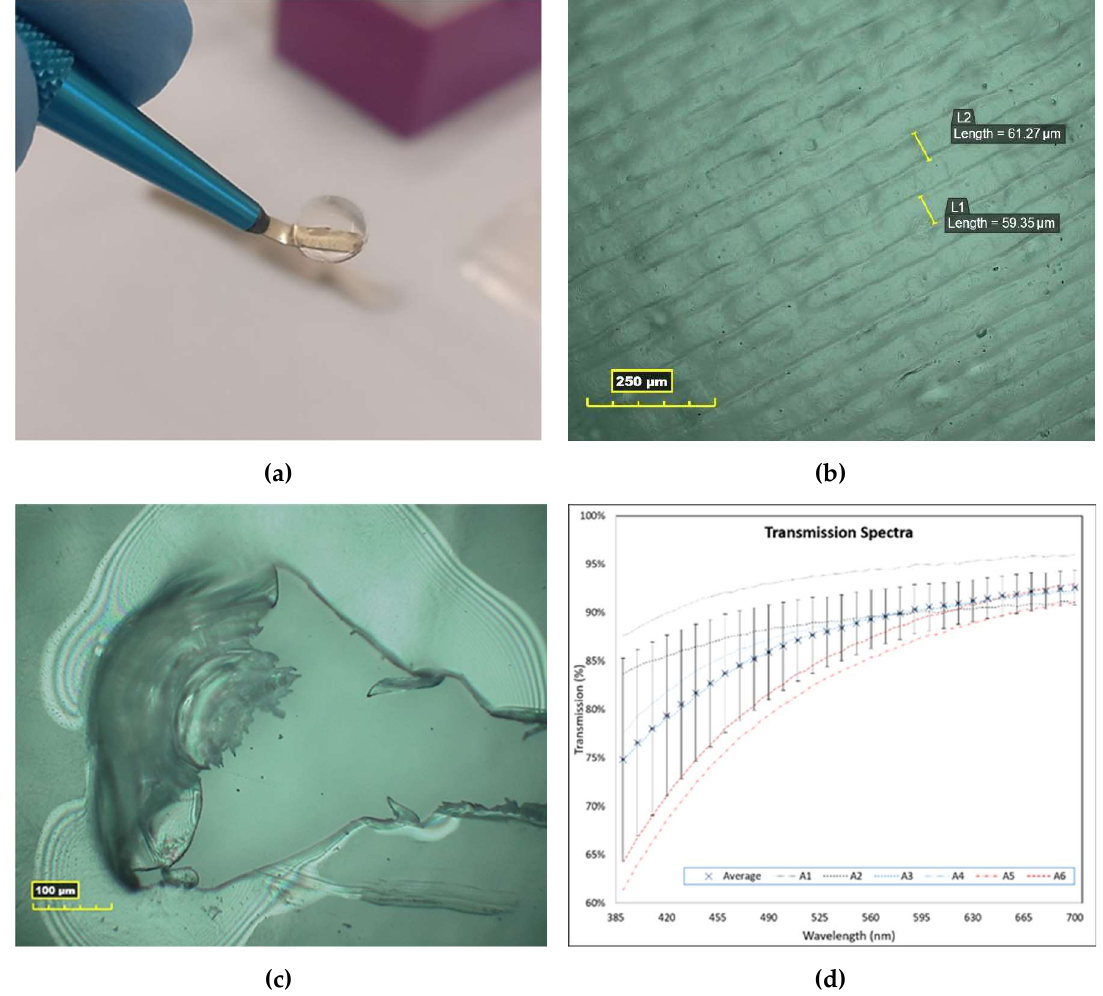
Figure 2. ( a ) A crosslinked 7 mm sample swollen in PBS held on a corneal scalpel; ( b ) print lines ≈60 µm in width in the centre of a 7 mm sample imaged under microscope after printing; ( c ) a failed sample in which a hole was torn to exhibit the birefringence seen in the samples. ( d ) The transmission spectra of each of the 7 mm samples measured, cross points with error bars represent the average transmission and standard deviation at 10 nm intervals.